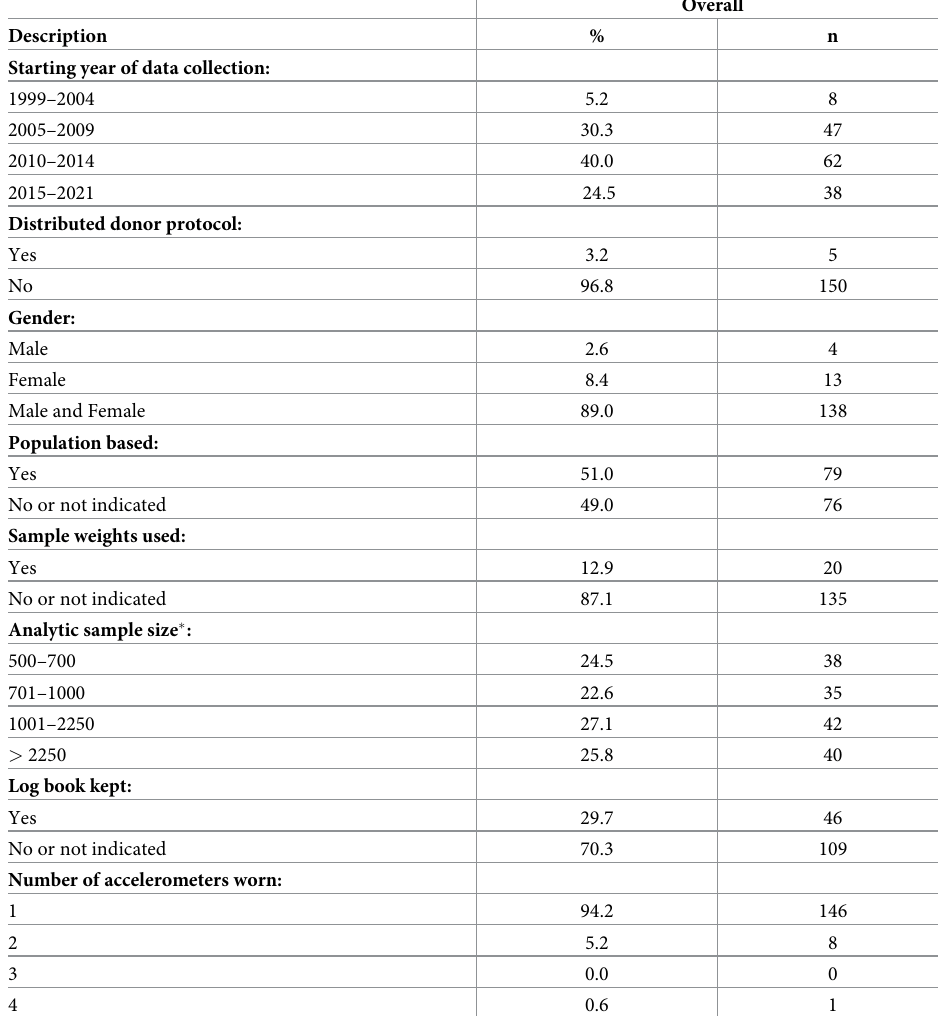
Table 1. Description of observational studies of adults collecting accelerometry (n =